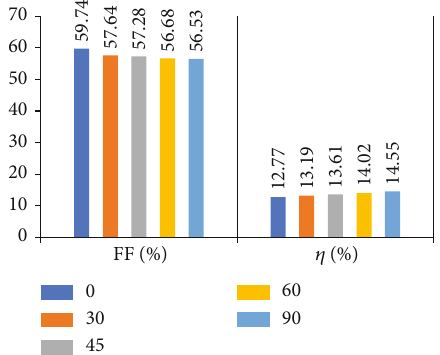
Figure 7: Fill factor and e ffi ciency of the PV module for di ff erent angles of inclination α and for an average solar irradiance of 630W.m -2 and B = 15 mT.